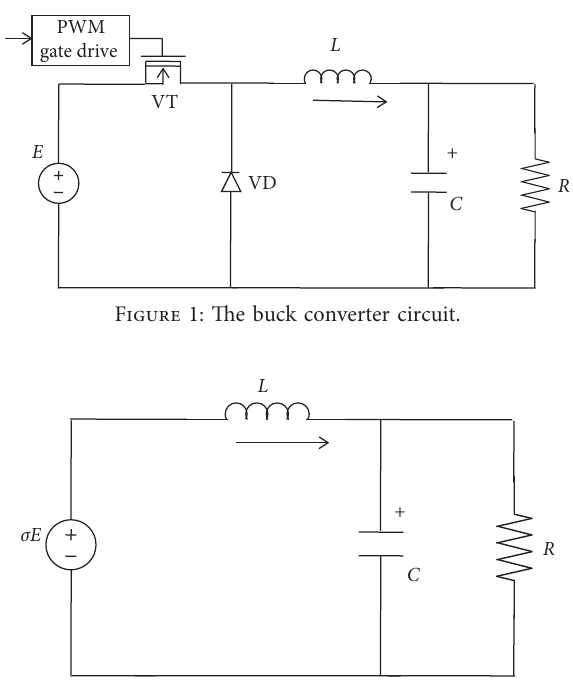
Figure 2: Equivalent circuit of Figure